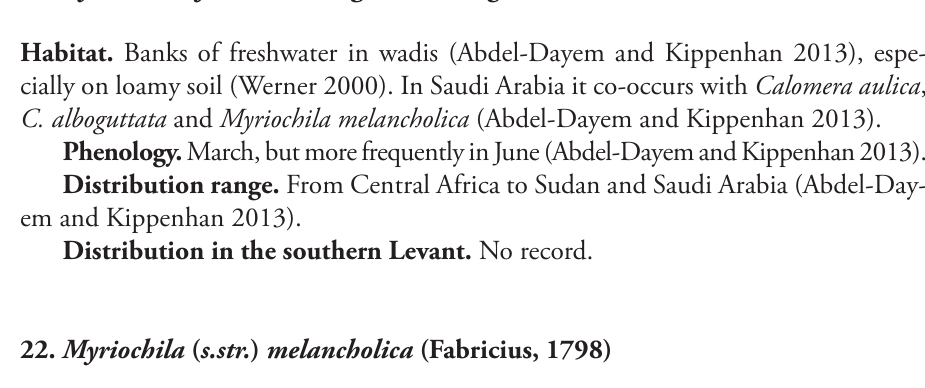
entire subspecies. Matalin and Chikatunov (2016) stated that the latest records date from the late 80s to the 90’s of the last century, and our most recent records are from 2003 (Shefeh Na’aman Nature Reserve, COQ). As the entire world population of this taxon is located in Israel (the majority of the known populations) and in Egypt, these countries bear the responsibility for the worldwide preservation of this